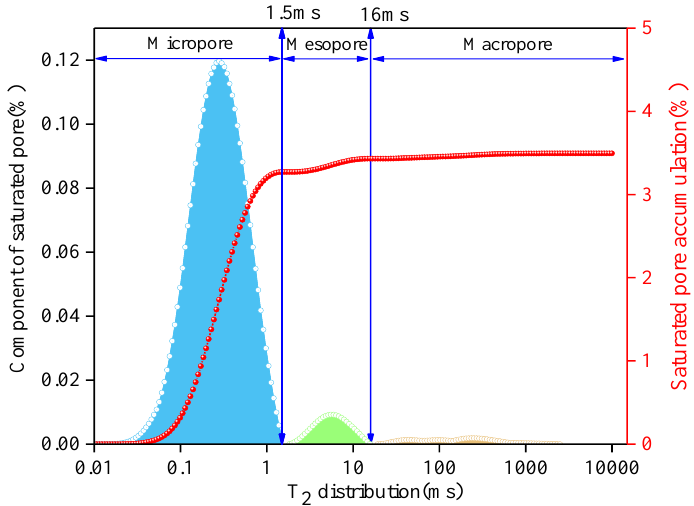
Figure 3. Pore radius division.